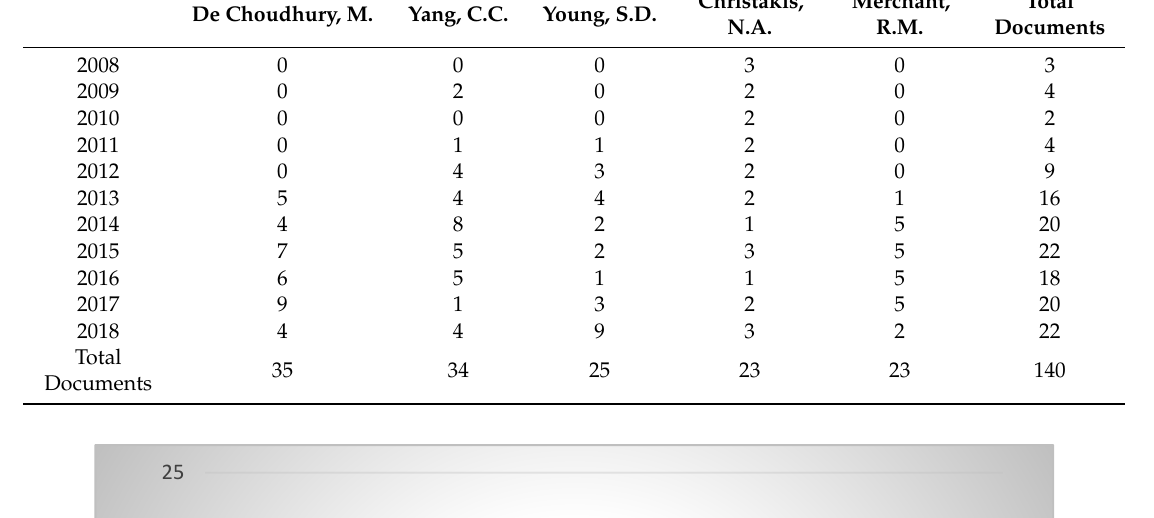
Table 6. Progress of the top five authors’ works during the last decade. De Choudhury, M.